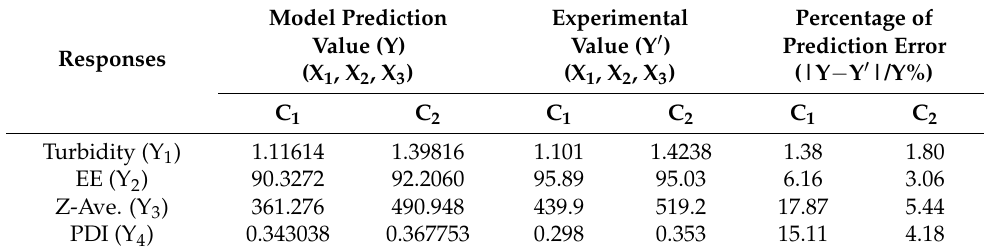
Figure 6. Overlapped contour plots of turbidity, encapsulation efficiency, particle size, and polydispersity index to define the design space of two independent variables with ( a ) a fixed SA value at 200 and ( b ) a fixed HWGA value at 200. *C 1 : GA/SA/AA = 150/200/15. *C 2 : GA/SA/AA = 200/200/15. To evaluate the accuracy of the derived overlapped contour plots, two additional experiments were carried out with two compositions, C 1 and C 2 , in the white area of the overlapped contour plots [23]. The prediction errors were between 1.38% and 17.87% for C 1 , and between 1.80%, and 5.44% for C 2 (Table 8). These results confirmed the suitability of the full quadratic model for the optimization of HWGA ‐ SA coacervates. The C 2 compo ‐ sition was selected as the optimized composition of coacervates for further study. Table 8. The additional test of prediction